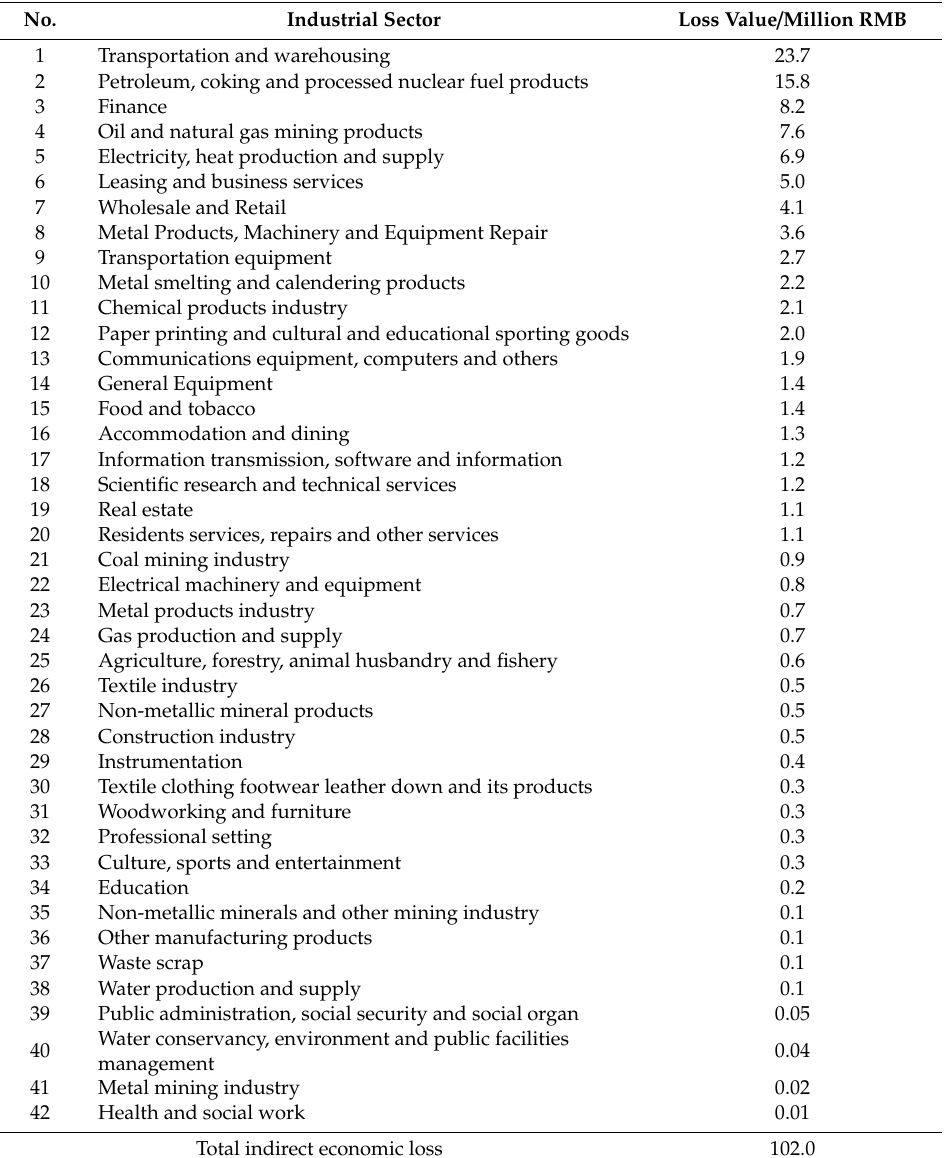
Table 3. Indirect economic loss for each industrial sector in